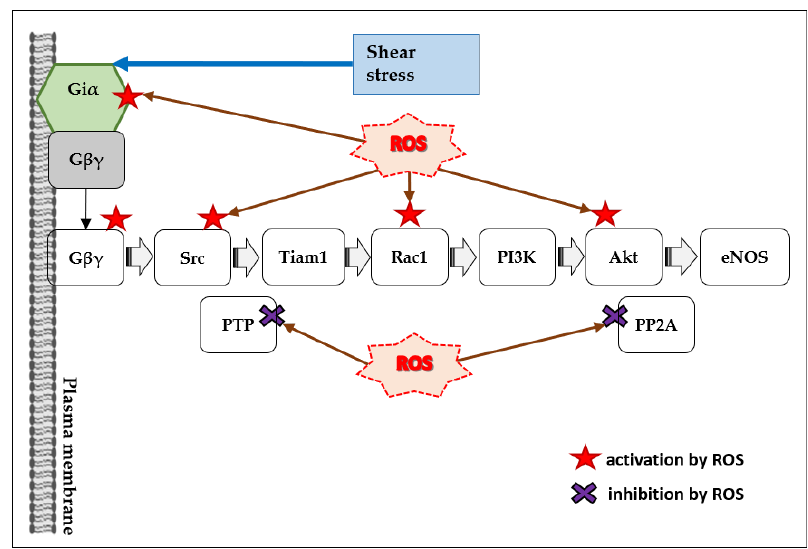
Figure 5. Scheme illustrating the potential involvement of ROS into flow-induced G i -mediated eNOS activation.